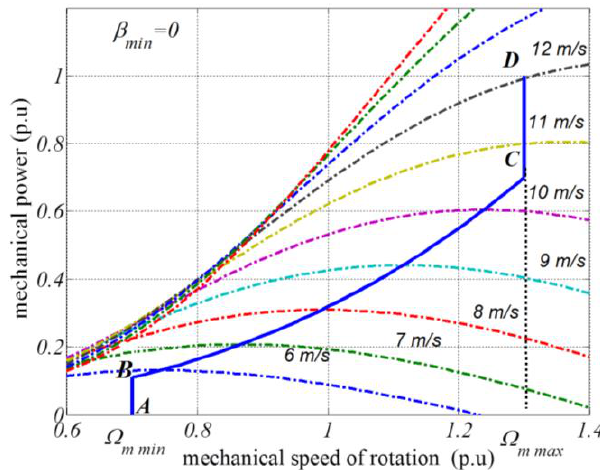
Figure 2. Wind turbine power characteristic DFIG ( P m vs. Ω m ).